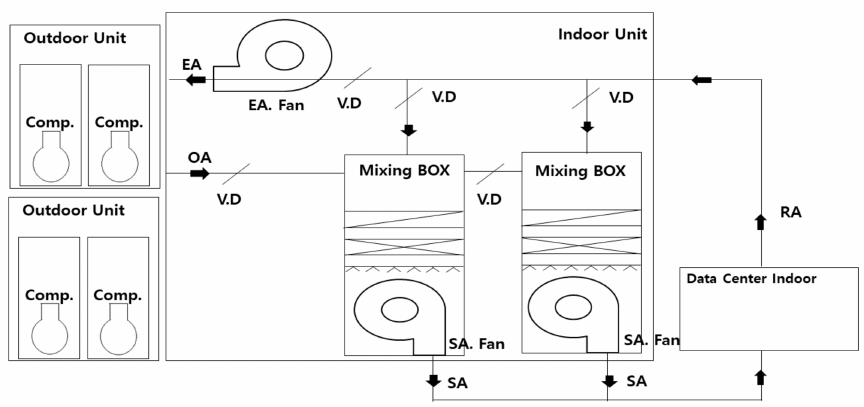
Figure 2. Schematic diagram of the outdoor air-cooling